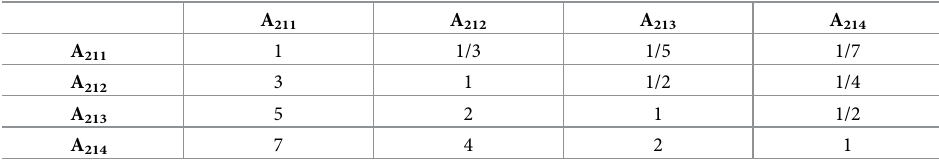
Table 10. Pairwise comparison matrix of the policy support indexes.